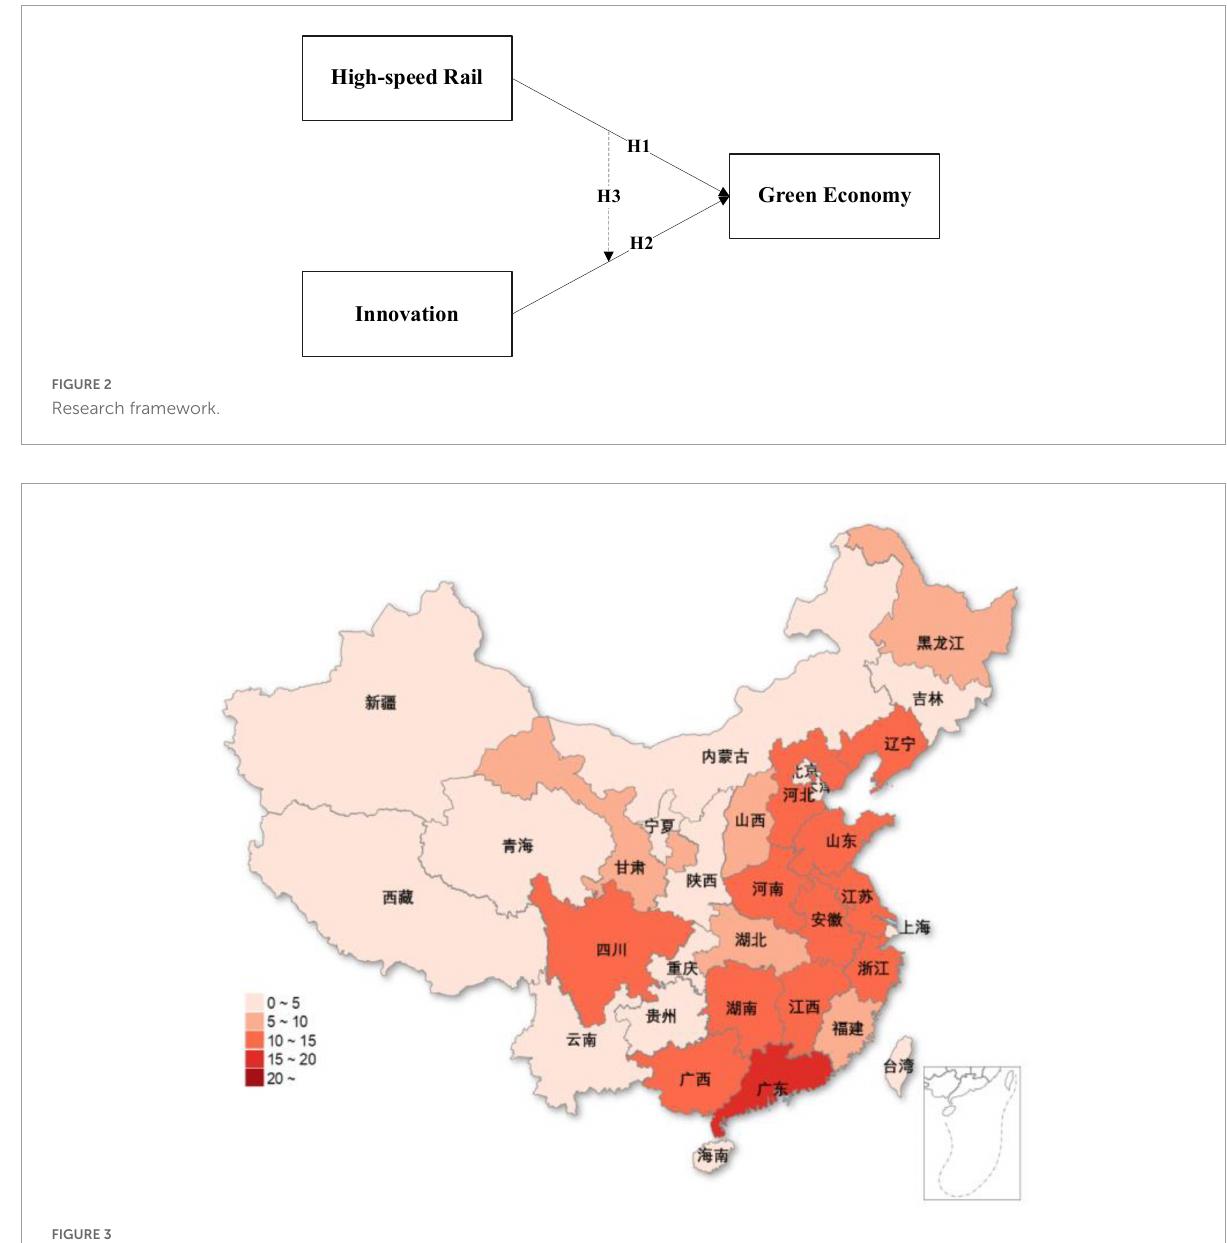
FIGURE3 The distribution of cities connected by high-speed rails in China.